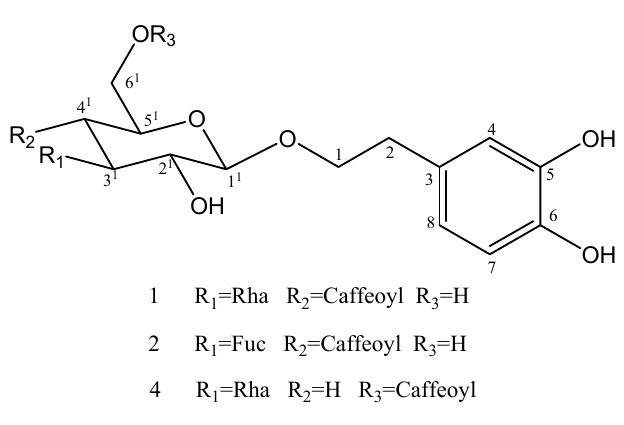
Figure 1. Structure of compounds 1 , 2 , 4 .